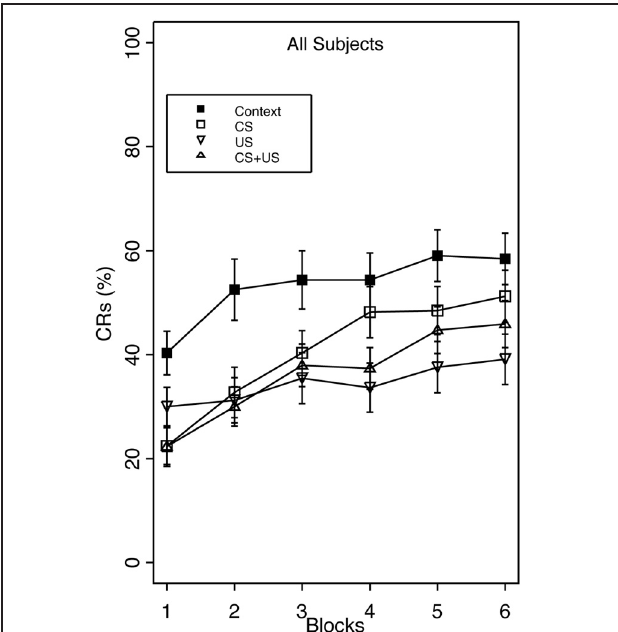
FIGURE 1 | Acquisition of the eyeblink CR during standard delay training for groups receiving Context, CS, US, or explicitly unpaired CS and US pre-exposures. The acquisition session consisted of 6 blocks of 10 paired CS/US trials. Robust proactive interference was apparent in all pre-exposure groups relative to Context pre-exposure. There was a significant main effect of Group, as well as an interaction of Group × Block. Group US and CS + US had significantly less total CRs than group Context. Interference after combined CS + US pre-exposures did not exceed interference elicited by either CS- or US-alone pre-exposures. Error bars represent the standard error of the